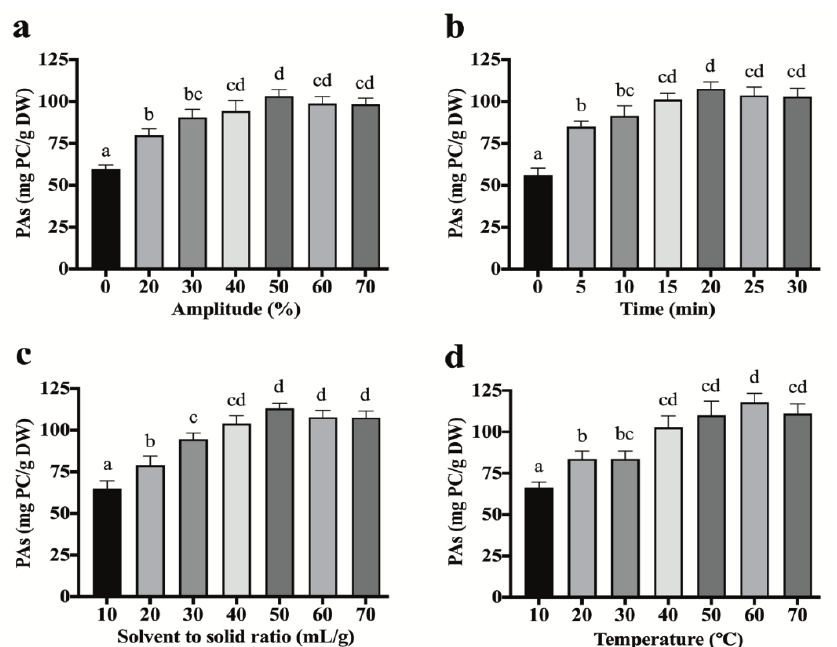
Figure 2. Single factor experiments of the UAE parameters’ effects on yield of PAs extracted from kiwifruit leaves: ( a ) ultrasonic amplitude; ( b ) extraction time; ( c ) solvent to solid ratio; and ( d ) extraction temperature. Mean ± SD with different alphabet superscript within the same column and analytical parameter indicate that values differ significantly ( p < 0.05).